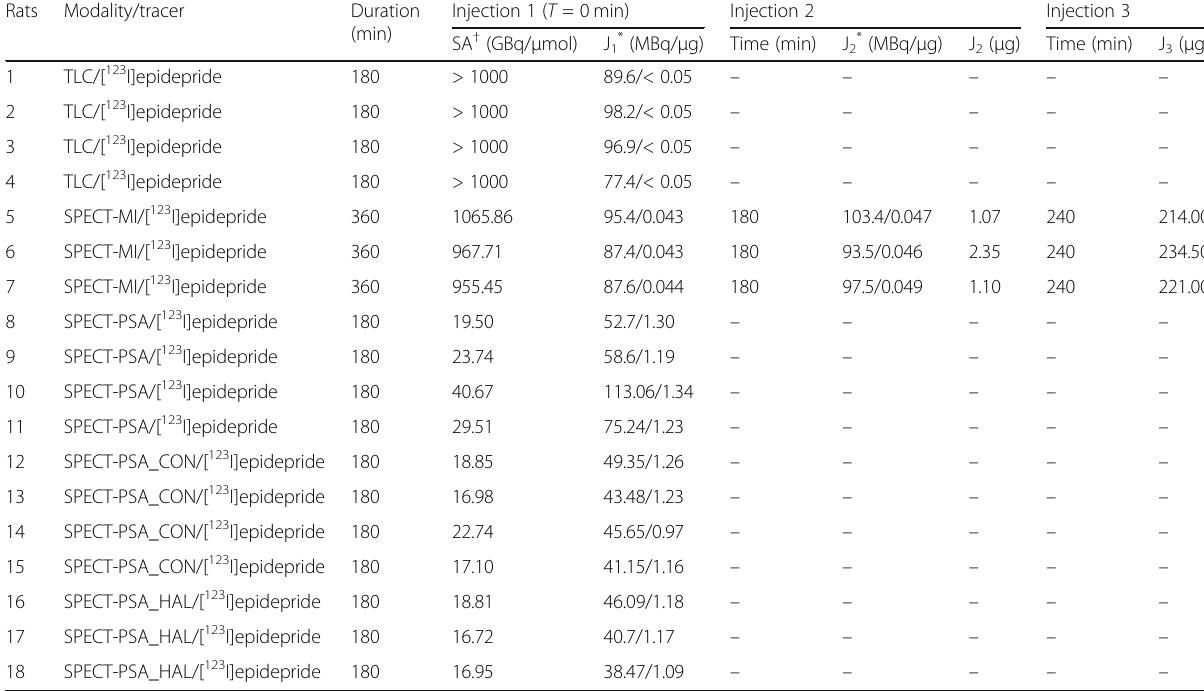
Table 1 Numerical values of the SPECT and metabolite protocol parameters corresponding to the 18 experiments Rats